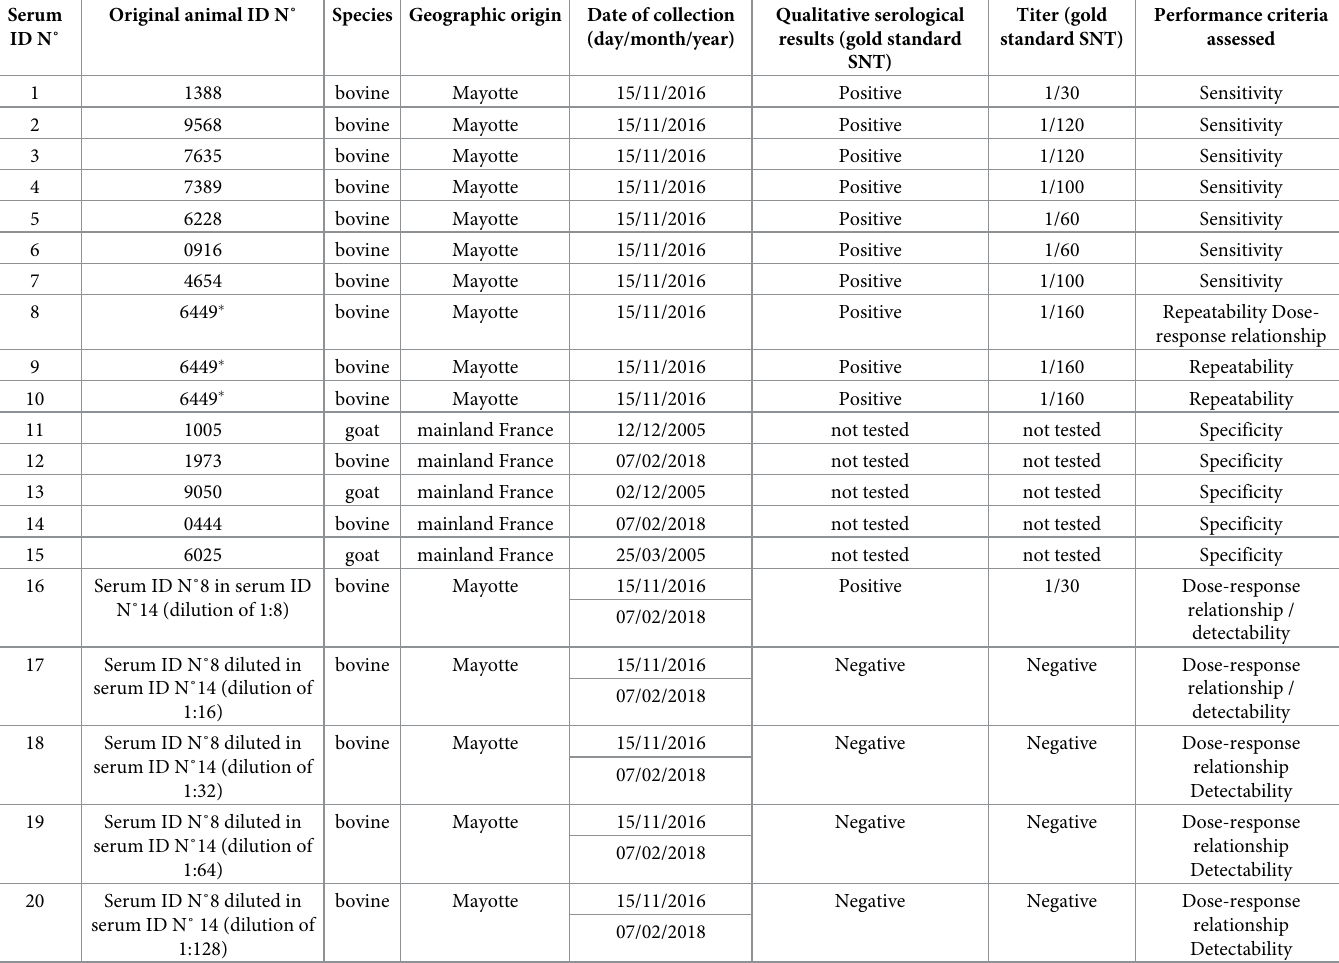
Table 1. Origin and status of the samples included in the panel used to assess the performance criteria.